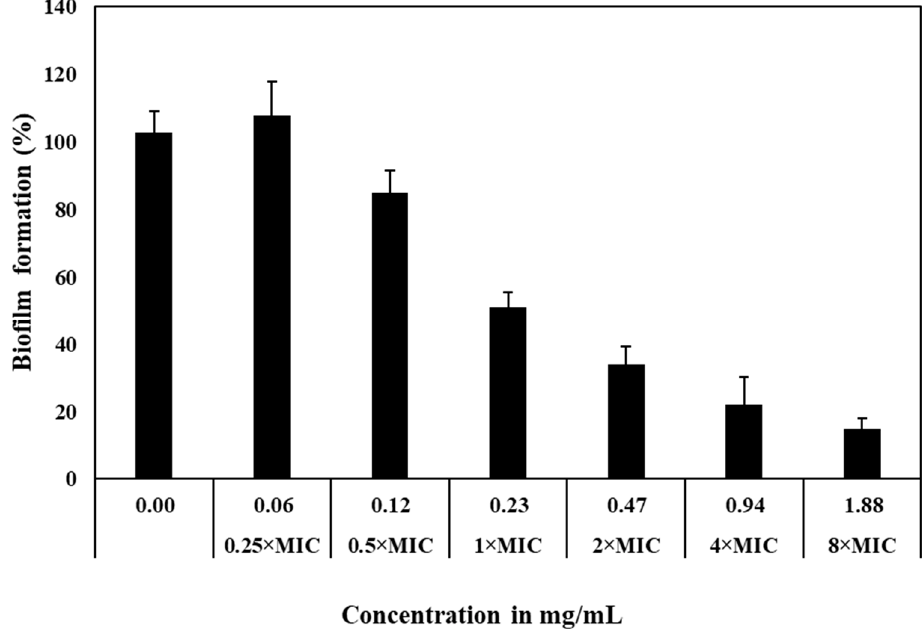
Figure 5. Effects of different OEO concentrations (mg/mL) on biofilm formation (%) of S. liquefaciens MDK33. Various concentrations of OEO were used: 0.25 × MIC (0.06 mg/mL), 0.5 × MIC (0.12 mg/mL), 1 × MIC (0.23 mg/mL), 2 × MIC (0.47 mg/mL), 4 × MIC (0.94 mg/mL) and 8 × MIC (1.88 mg/mL). Biofilm formation of 100% in the control corresponds to an OD 530 of 0.48 ± 0.05 where no OEO was added (0 mg/mL) and the bacterial strain was able to form biofilm without inhibition.